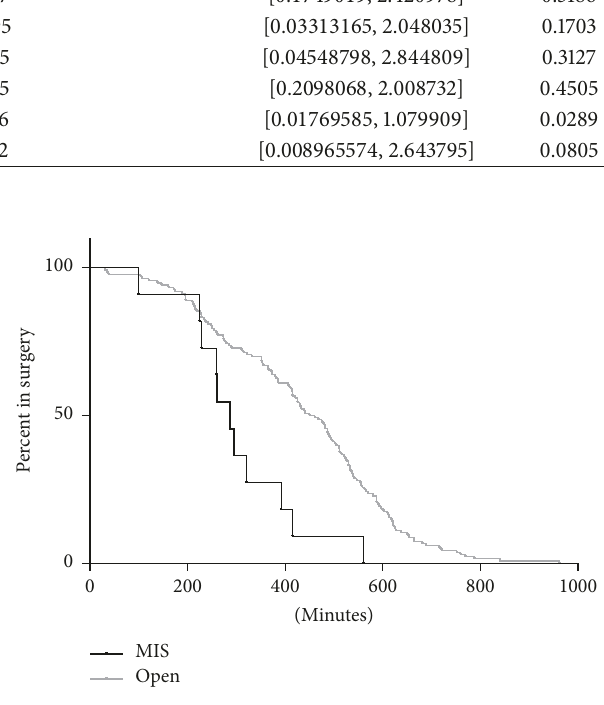
Figure 2: Comparison in surgery length between MIS and open approach